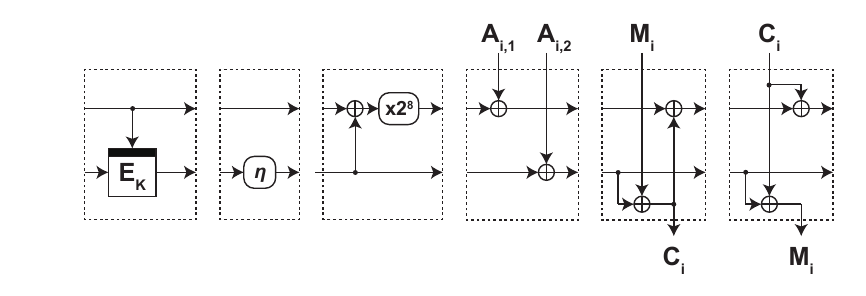
Figure 5: Breakdown of AES - LBBB into several commands